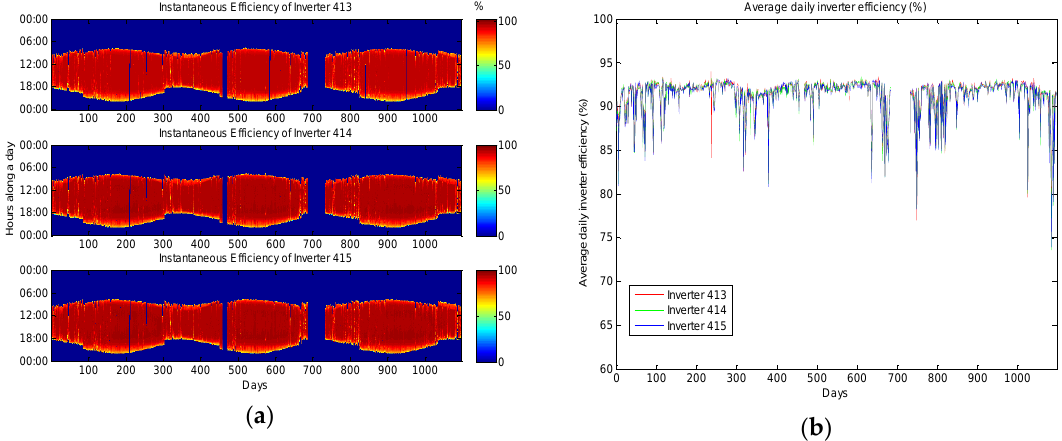
Figure 12. Inverters’ efficiency from 1 January 2011 to 31 December 2013: ( a ) instantaneous values, during 24 h a day; and ( b ) total daily values.